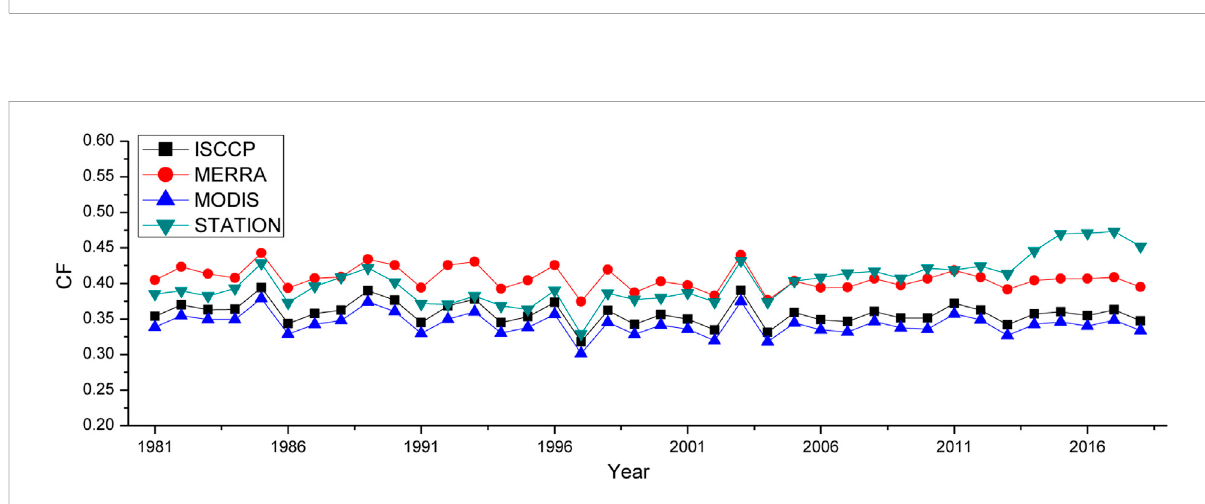
FIGURE 7 Time series of the annual cloud fraction in NR for four datasets (ISCCP, MERRA, MODIS, and station